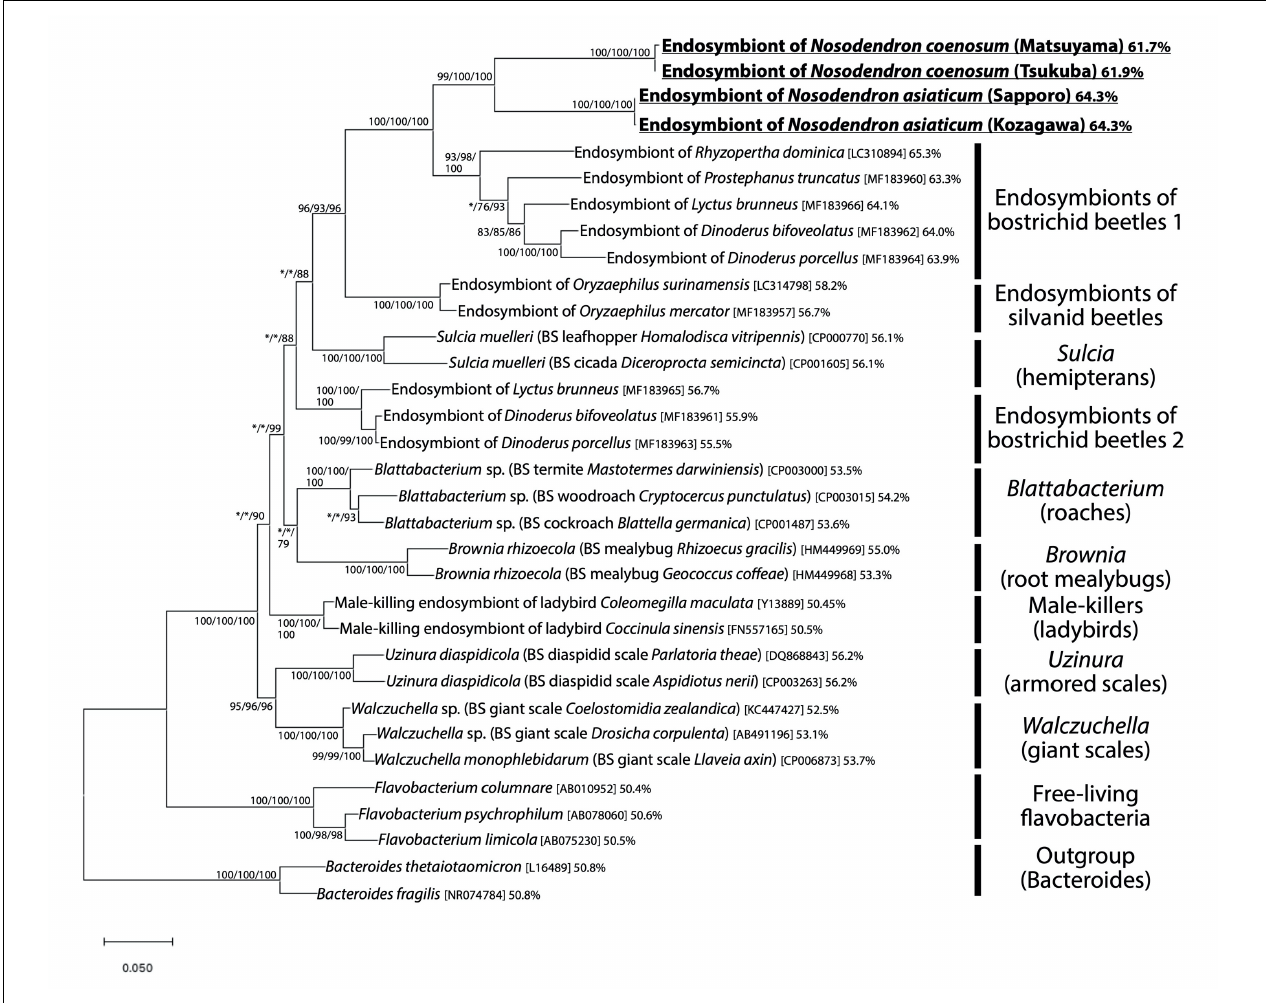
FIGURE 2 | Phylogenic placement of the endosymbiotic bacteria of Nosodendron beetles based on 16S rRNA gene sequences. A maximum-likelihood phylogeny inferred from 1,178 aligned nucleotide sites is shown. Statistical support probabilities are shown on each node in the order of neighbor-joining/maximum- likelihood/Bayesian methods, where values less than 70% are indicated by asterisks. For each bacterial sequence, host-related information in parentheses, accession number in brackets, and AT content in percentage are shown. “BS” indicates bacteriocyte-associated endosymbiont. The explanation of each major clade is depicted on the right